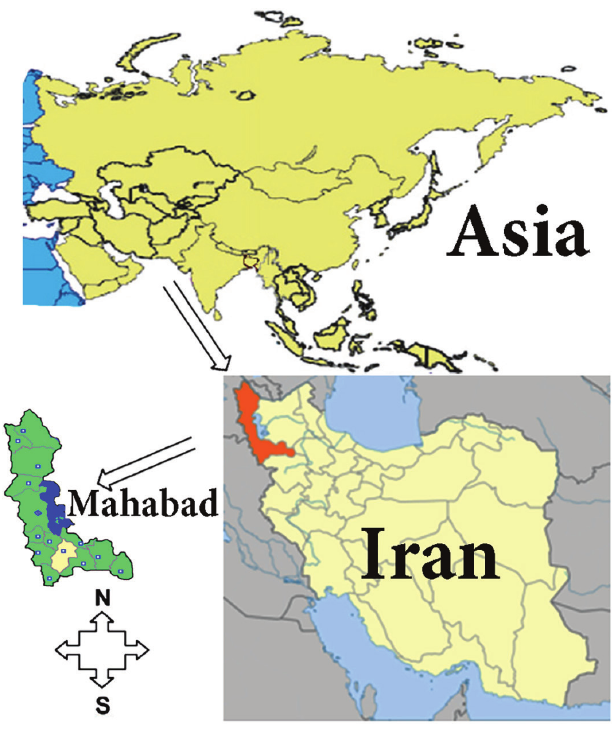
FIGURE 1 - Location of study area, Mahabad, in Iran